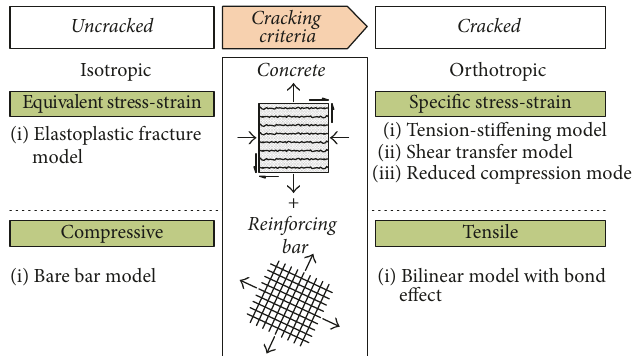
Figure 12: Outline of analysis model for reinforced high-strength concrete [15].